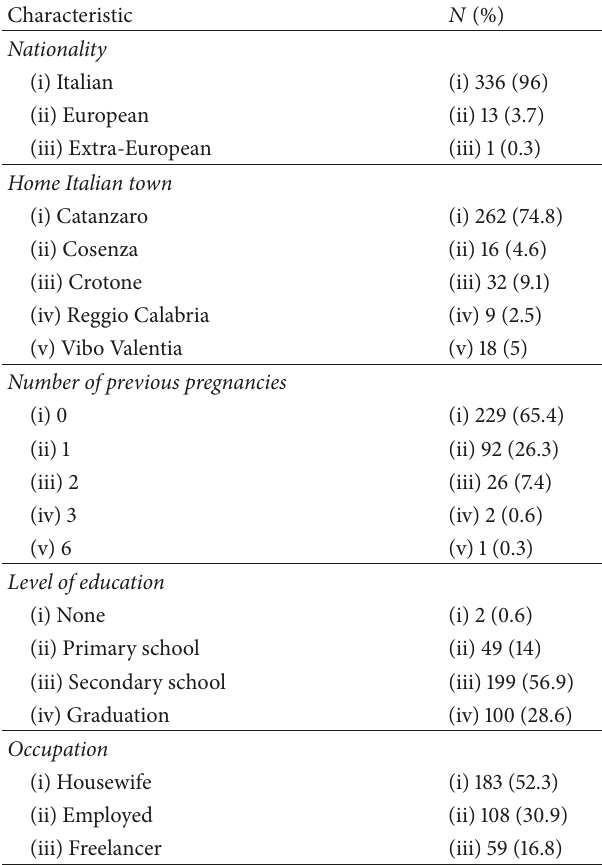
Table 2: Characteristics of the enrolled women ( 𝑁 = 350 ).